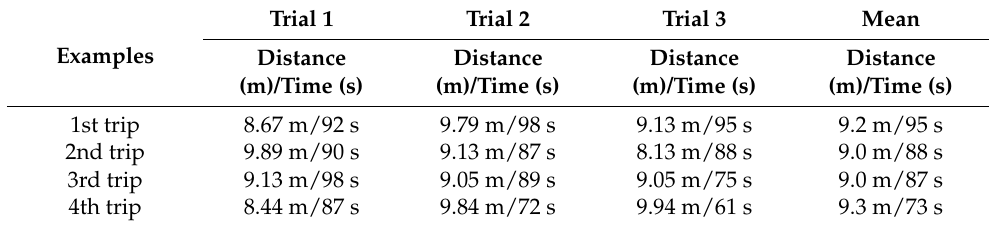
Table 4. Experimental data for different